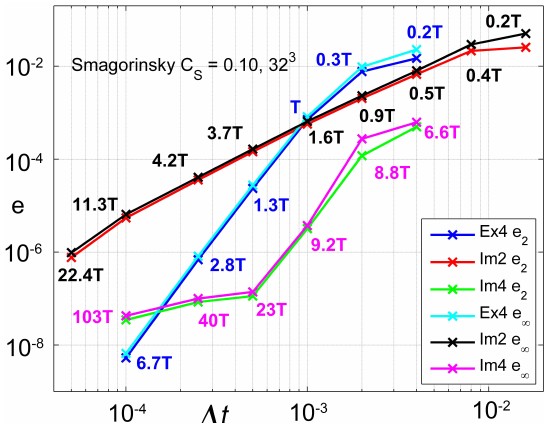
Figure 3. An error analysis based on the decay of TKE on a 32 3 grid. The reference solution is obtained with Ex4 and a time step of 0.0002 s. T is the time required to obtain a solution with Ex4